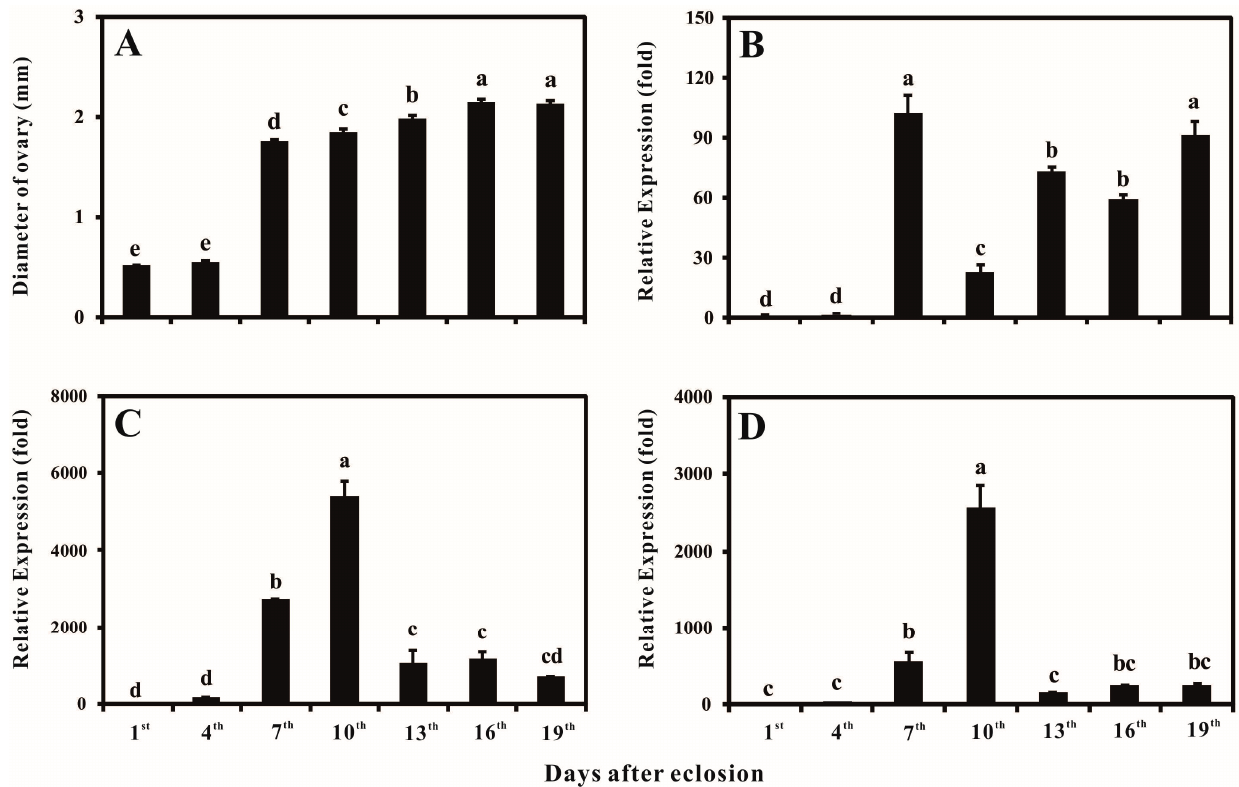
Figure 4. The growth of ovary and temporal-expression patterns of BdVgR , Bdyp1 and Bdyp2 : ( A ) the developmental status of ovaries; ( B ) the temporal-expression pattern of BdVgR ; ( C ) the temporal-expression pattern of Bdyp1 ; ( D ) the temporal-expression pattern of Bdyp2 . The bars represented the mean ± SE. Different letters indicated significant difference with ANOVA (Least Significant Difference, LSD, p <